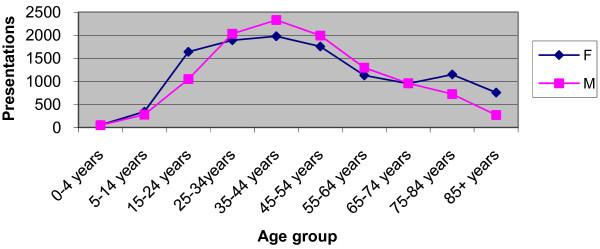
Presentations by Gender and Age Group.